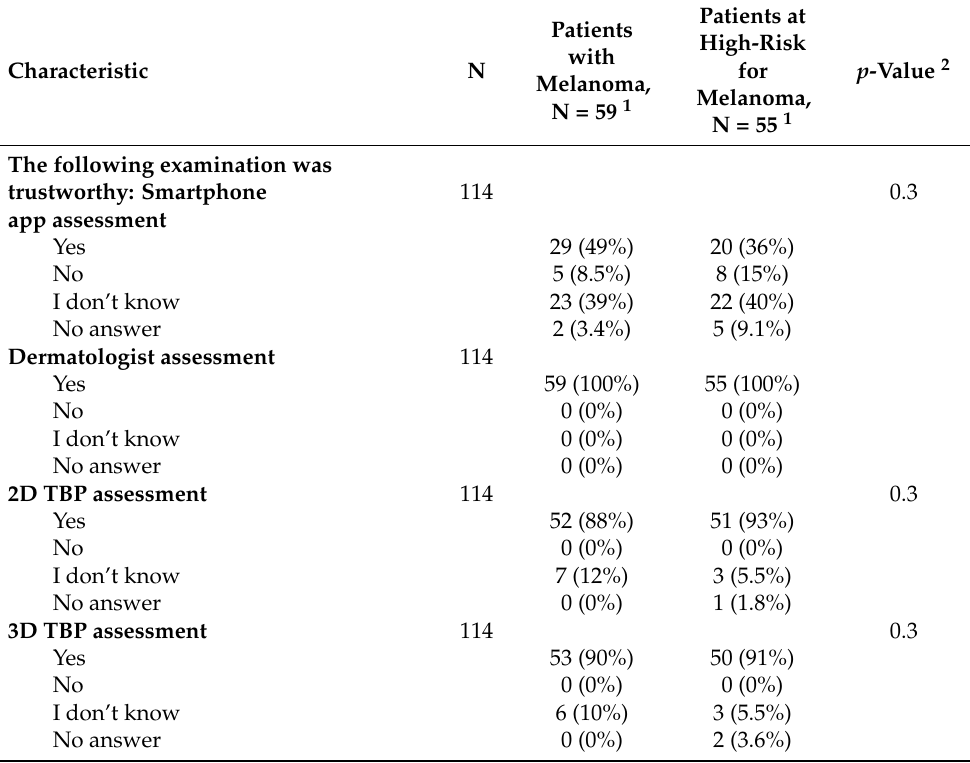
Table 4. Assessment of trustworthiness of the AI-based smartphone app SkinVision ® , 2D imaging FotoFinder ATBM ® , and 3D imaging Vectra ® WB360 compared to dermatologists.